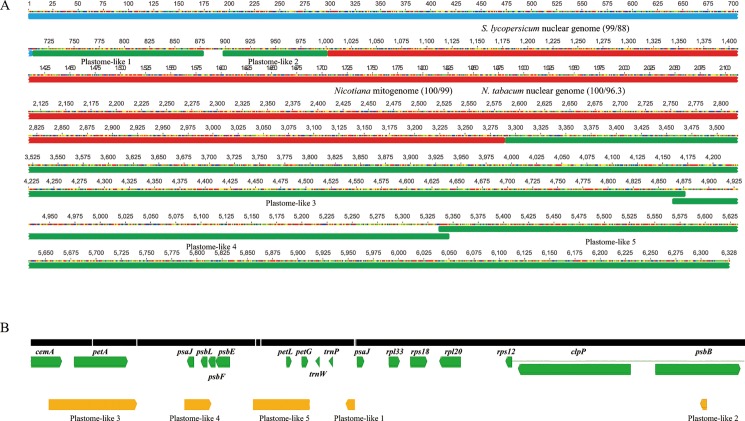
A 6,328-bp region specific to the Solanum pennellii mitogenome and plastome counterparts of five mitochondrial plastid DNAs (MTPTs).A) The 6,328-bp region comprised three parts: five MTPTs (green boxes), a region similar to the tomato nuclear genomic region (blue box), and regions similar to the mitogenome and nuclear genome of Nicotiana tabacum (red box). Numbers within parenthesis represent the query cover and identity, respectively, of a similar taxon using blastn analysis. B) Five MTPTs assembled in a plastome sequence (black bar). The green and yellow boxes indicate plastome genes and plastome-like regions, respectively.